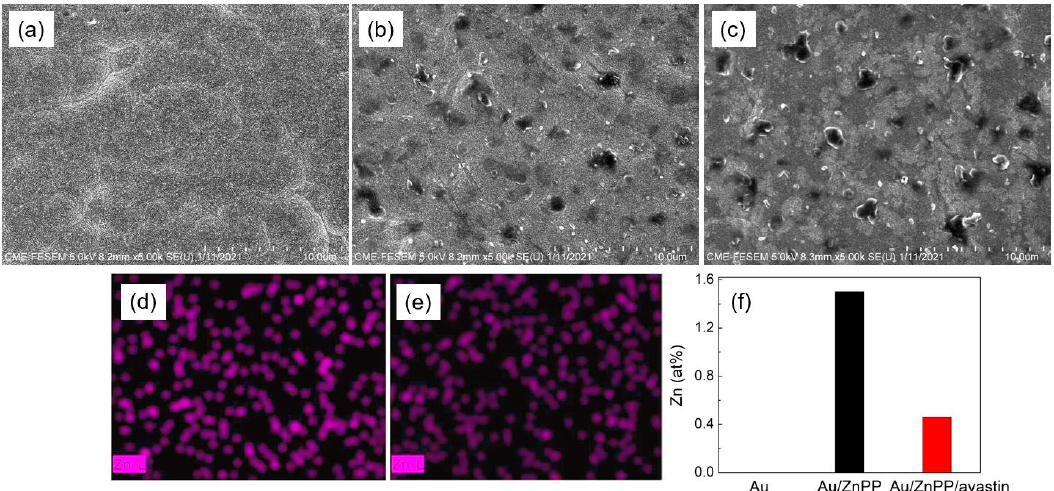
Figure 2. Images of the ( a ) Au electrode, ( b ) Au/ZnPP electrode, ( c ) Au/ZnPP/Avastin electrode and the energy-dispersive X-ray spectroscopy (EDX) mappings of zinc atom on ( d ) Au/ZnPP electrode, and ( e ) Au/ZnPP/Avastin electrode. Percentage of zinc atoms on the Au/ZnPP and Au/ZnPP/Avastin electrodes (f). The field-emission scanning electron microscopy (FESEM) and EDX scales are 5000×.